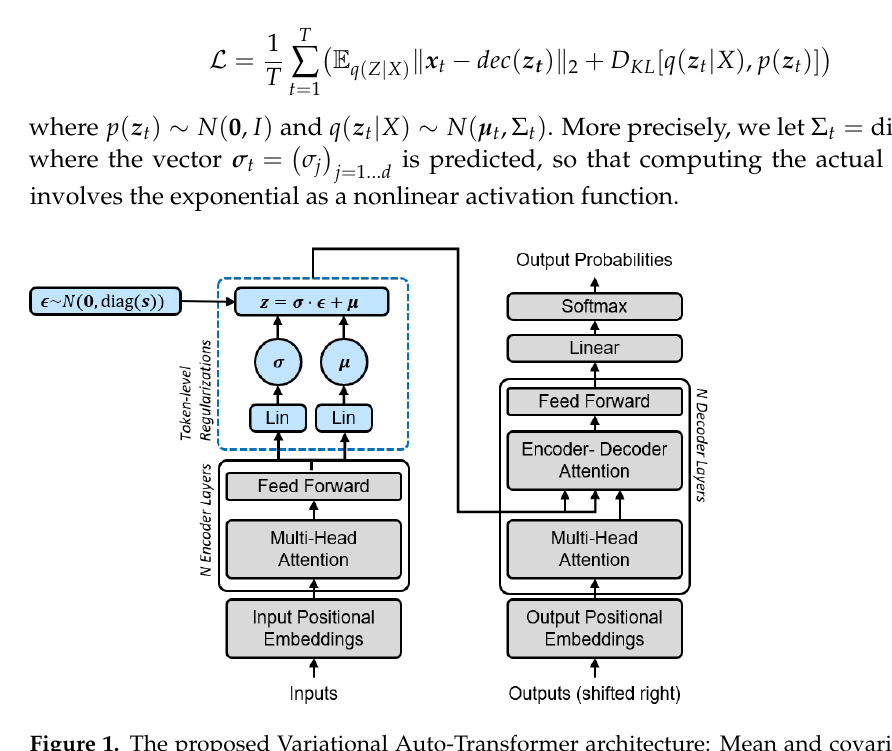
Figure 1. The proposed Variational Auto-Transformer architecture: Mean and covariance for the variational loss (blue, dashed lines) are computed through two independent linear layers. The encoder and decoder (grey, solid lines) architecture is the same as in the original